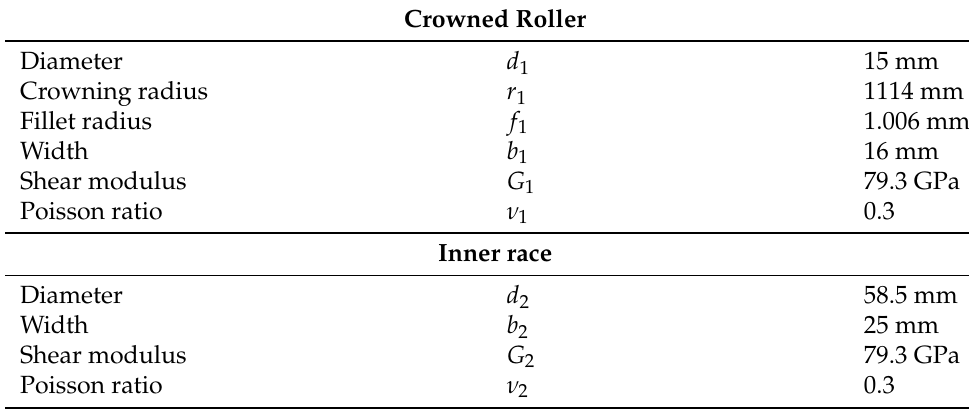
Table 2. Crowned roller and inner race geometrical and material properties, from